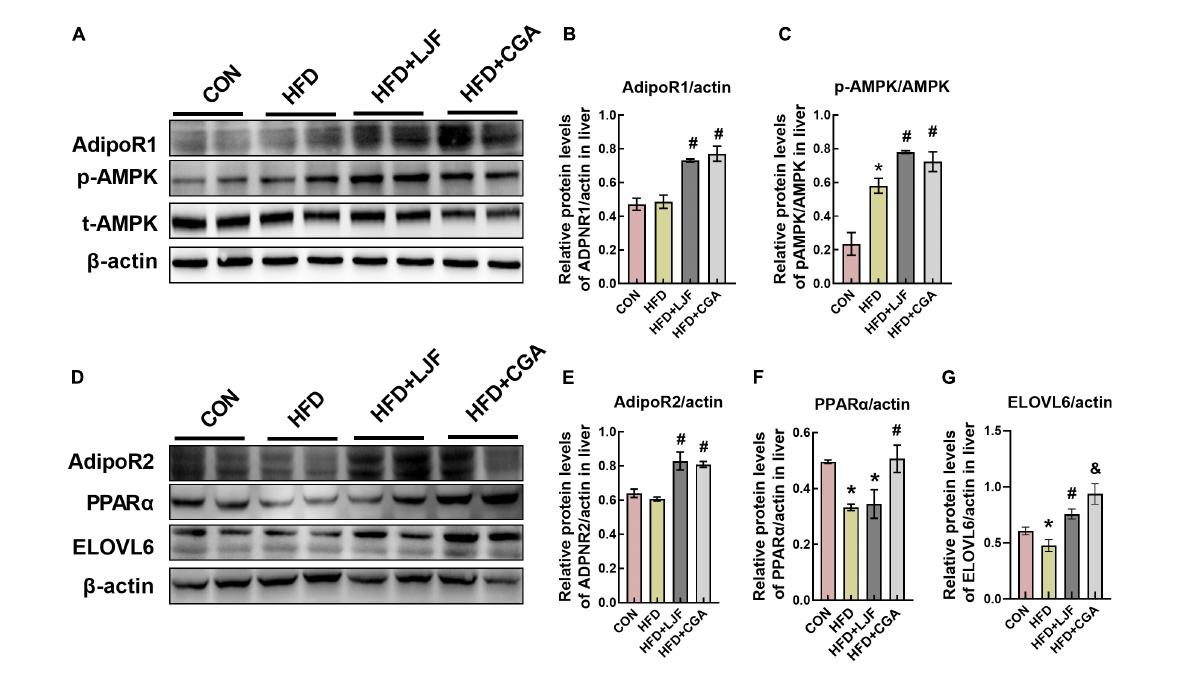
FIGURE7 Lonicerae Japonicae Flos and CGA up-regulated expression levels of AdipoR1, AdipoR2, and ELOVL6 proteins in rat liver. (A–G) Protein levels and densitometric quantification of adiponectin receptors (AdipoR1 and AdipoR2), ELOVL6, p-AMPK, AMPK, PPAR- α , and β -actin, bars represent densitometric quantification normalized to β -actin. All bars show means ± SEM. ( n = 4 per group). * P < 0.05, vs. CON group; # P < 0.05, vs. HFD group; & P < 0.05, vs. HFD +